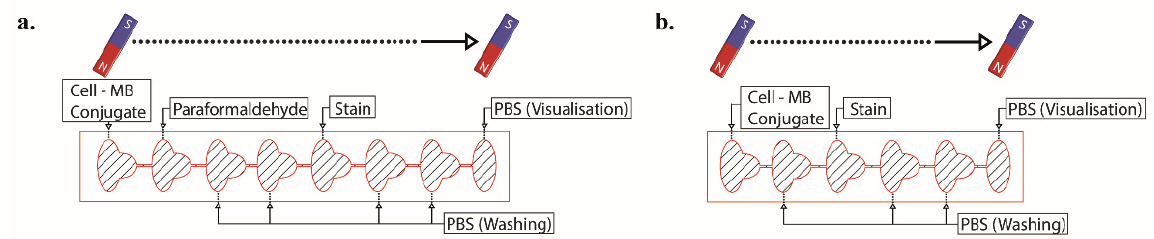
Figure 2. Schematic design of the chip with eight ( a ) and six ( b ) compartments for on-chip and off-chip configuration, respectively, and staining process showing solutions in compartments.